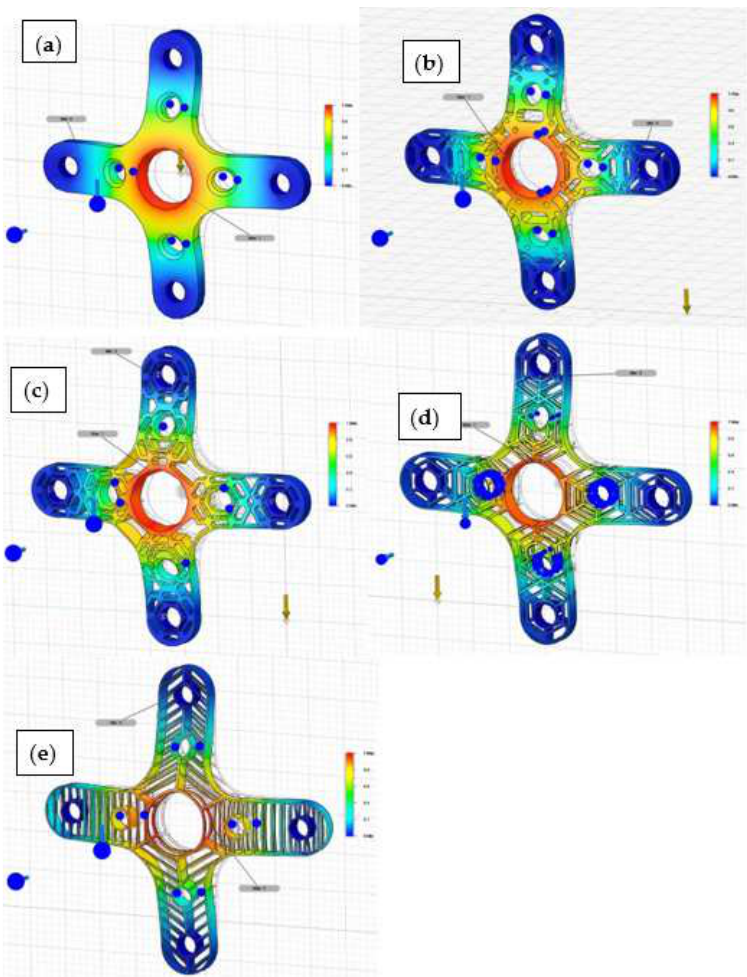
Figure 13. Modal frequencies simulation analysis of ( a ) original holder, ( b ) polyhedral, ( c ) snowflake, ( d ) circular spiderweb, and ( e ) linear spiderweb.